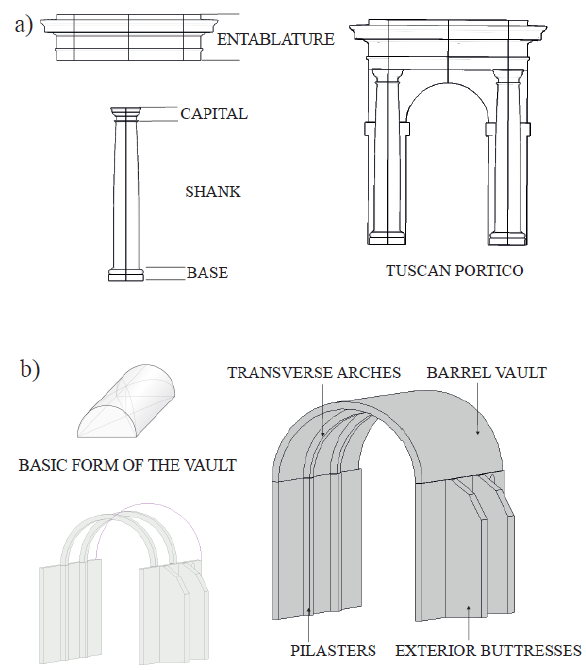
Fig. 7. Parametric objects library; a) Tuscan portico; b) barrel vault